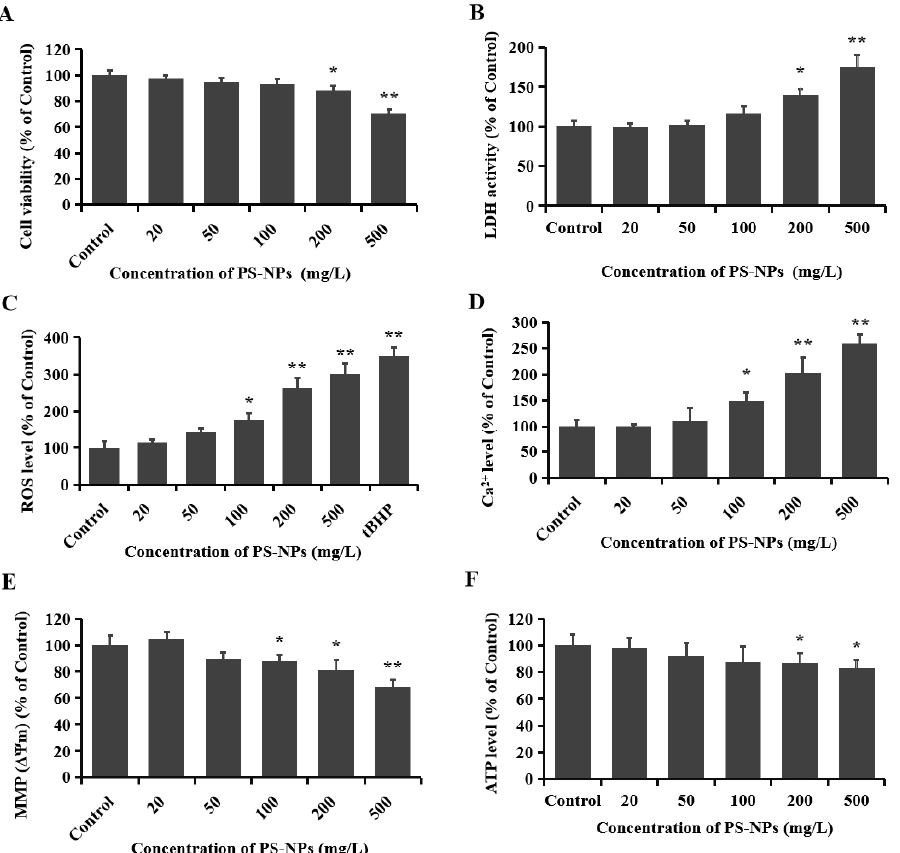
Figure 1. The cytotoxicity induced by PS-NPs in SHSY-5Y cells. SHSY-5Y cells were treated with different concentrations (20, 50, 100, 200, and 500 mg/L) of PS-NPs for 24 h. Then, cytotoxicity was measured. ( A ): Cell viability was measured with MTT. ( B ): LDH activity was detected using a LDH assay kit. ( C ): ROS production was measured using a fluorescent probe DCFH-DA, and tBHP (100 μ M, 1 h) was used as a positive control for oxidative stress. ( D ): Ca 2+ content was examined using the fluorescent probe Fluo-3AM (5 μ M). ( E ): MMP ( Δψ m) was measured using the fluorescent probe Rh 123 (10 μ M). ( F ): ATP level was measured using an ATP assay kit. The fluorescence intensity was converted as a percentage compared with the control. In the control group, SHSY-5Y cells were only treated with RPMI 1640 medium. * p < 0.05 and ** p < 0.01, compared to the control.